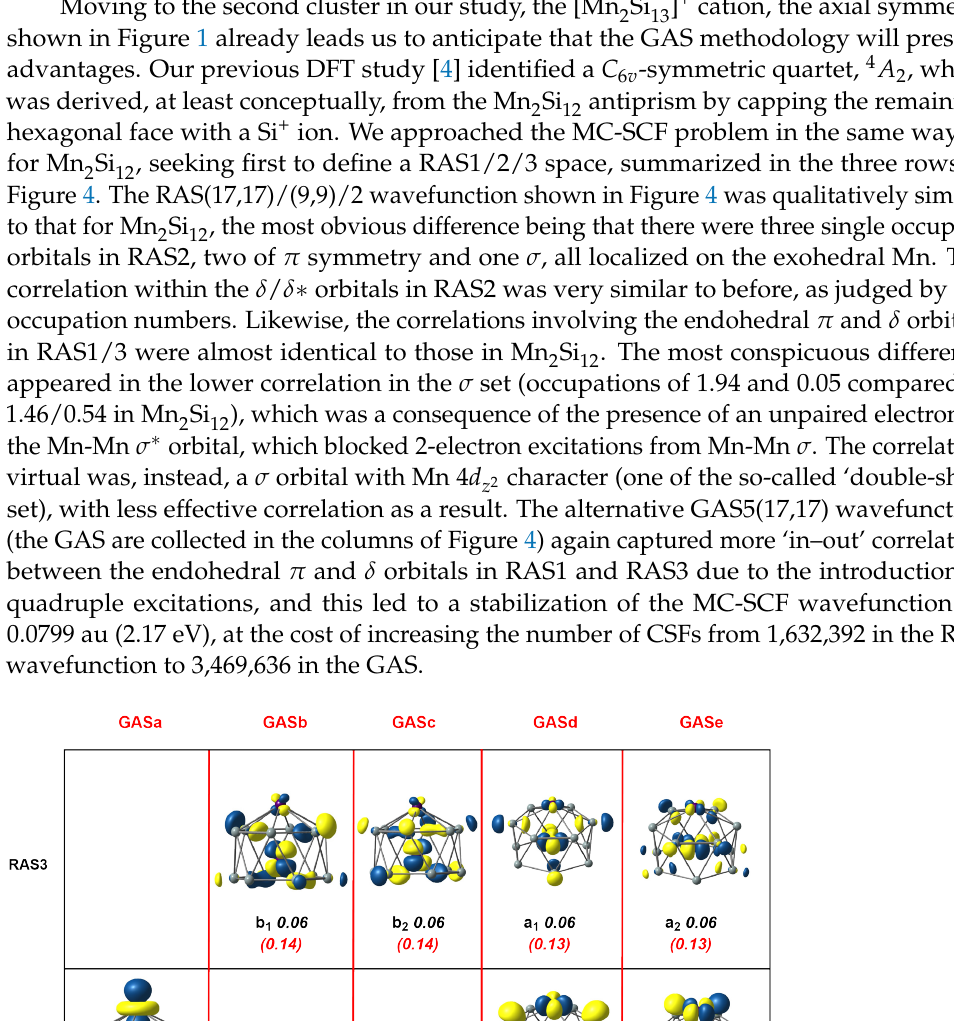
Si . Occupation numbers from the generalized active space 2 12 Si used the C 2 v subgroup rather than 2 12